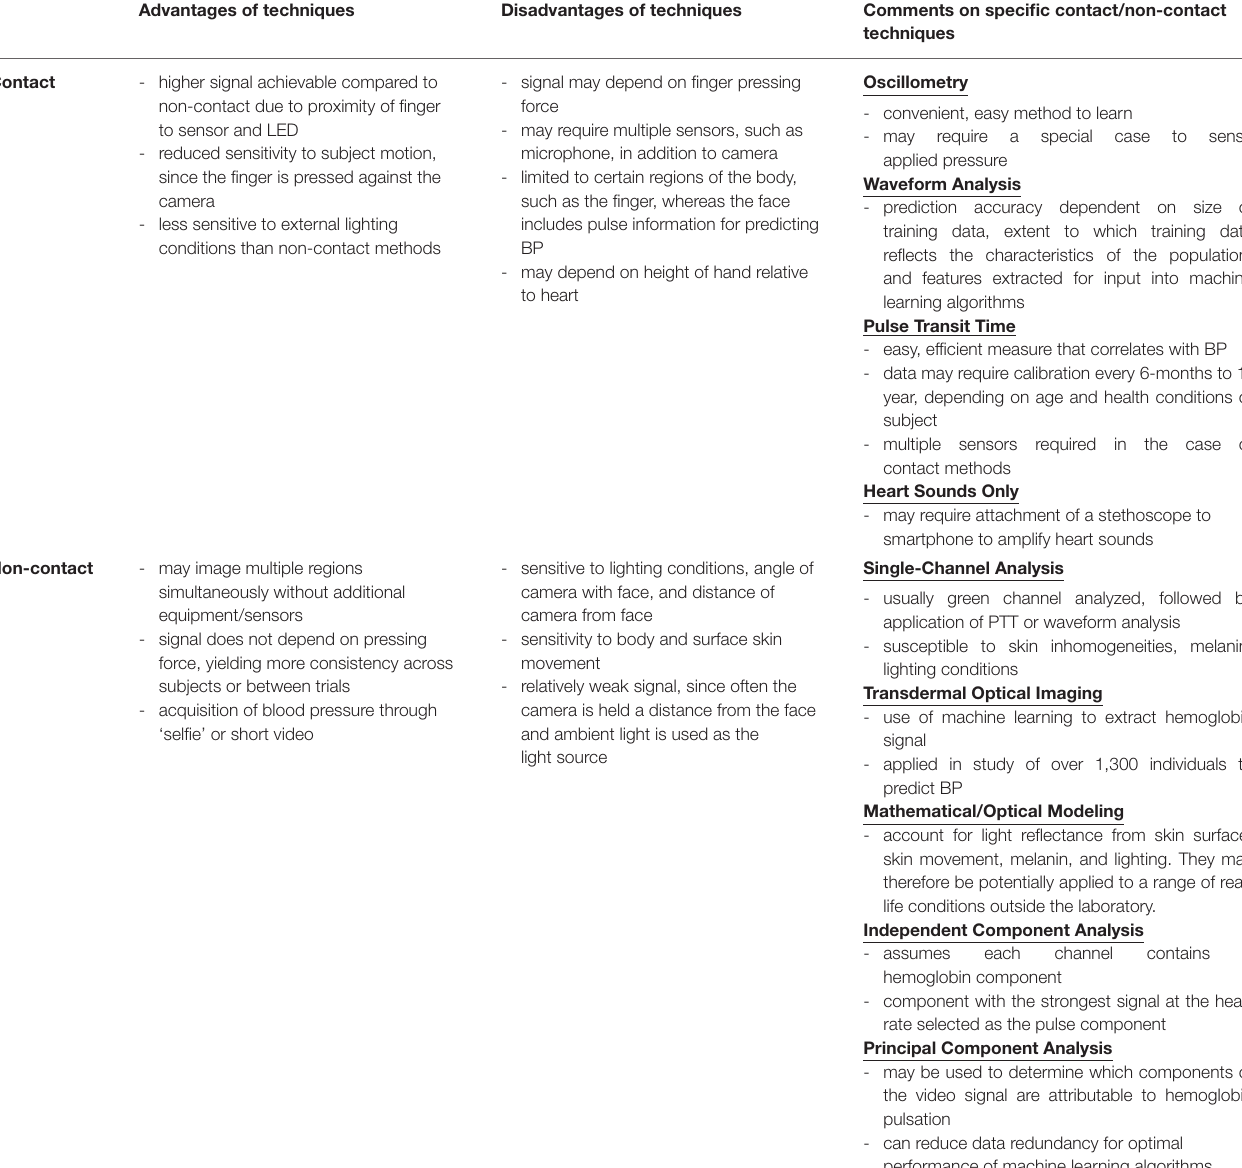
TABLE 3 | Comparison of contact and non-contact BP measurement